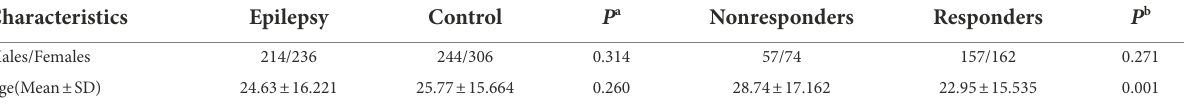
TABLE 1 Characteristics of the patients and controls.